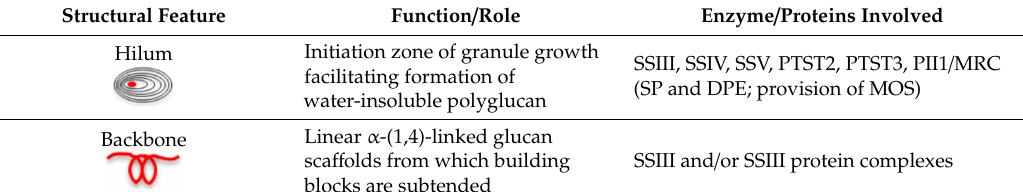
Table 1. Biological agents responsible for synthesis of fine structure components of